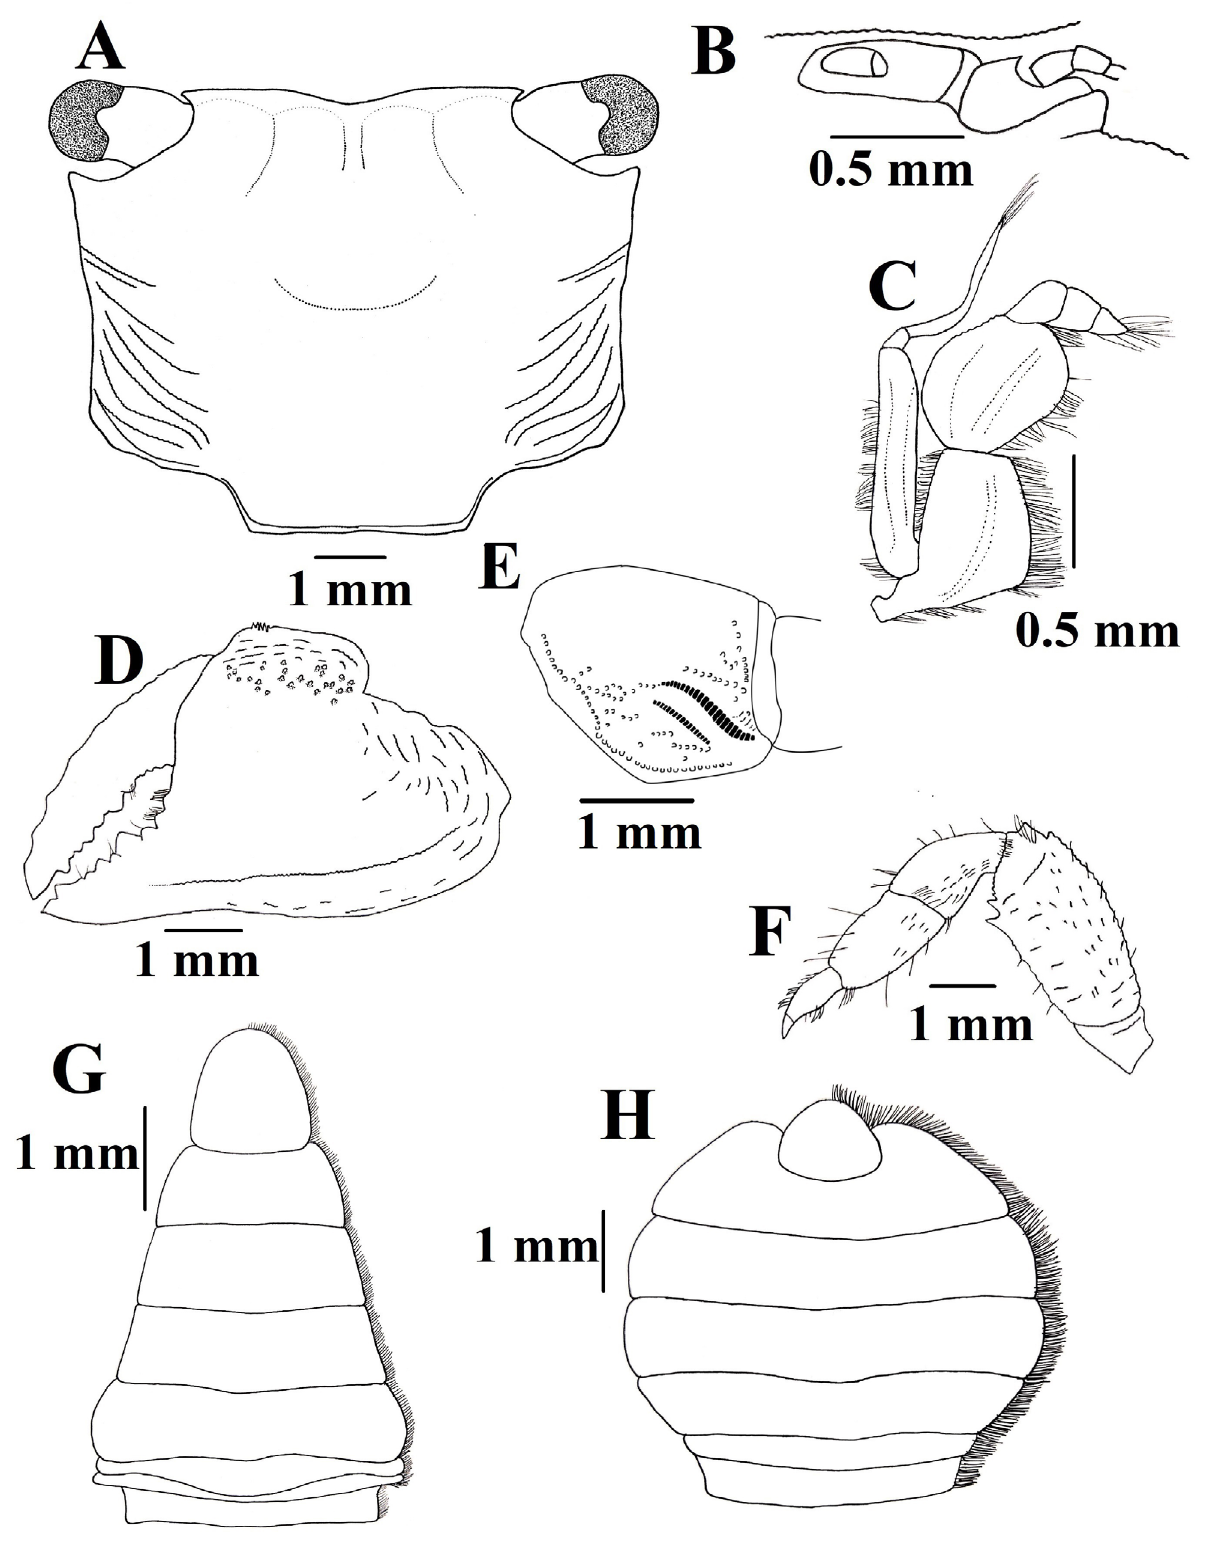
Figure 2. Nanosesarma andersoni (De Man, 1888). A – G , Male (LFSC.ZRC-185) (CL: 4.8 mm; CW: 6.5 mm), Chapora Estuary, Goa, India; H , female (LFSC.ZRC-185) (CL: 4.3 mm; CW: 5.8 mm), Chapora Estuary, Goa, India. ( A ) Carapace; ( B ) basal antennular and antennal articles; ( C ) right third maxilliped; ( D ) palm of left cheliped (outer face); ( E ) dorsal view of left cheliped palm; ( F ) left P5 (dorsal view); ( G ) male pleon; ( H ) female